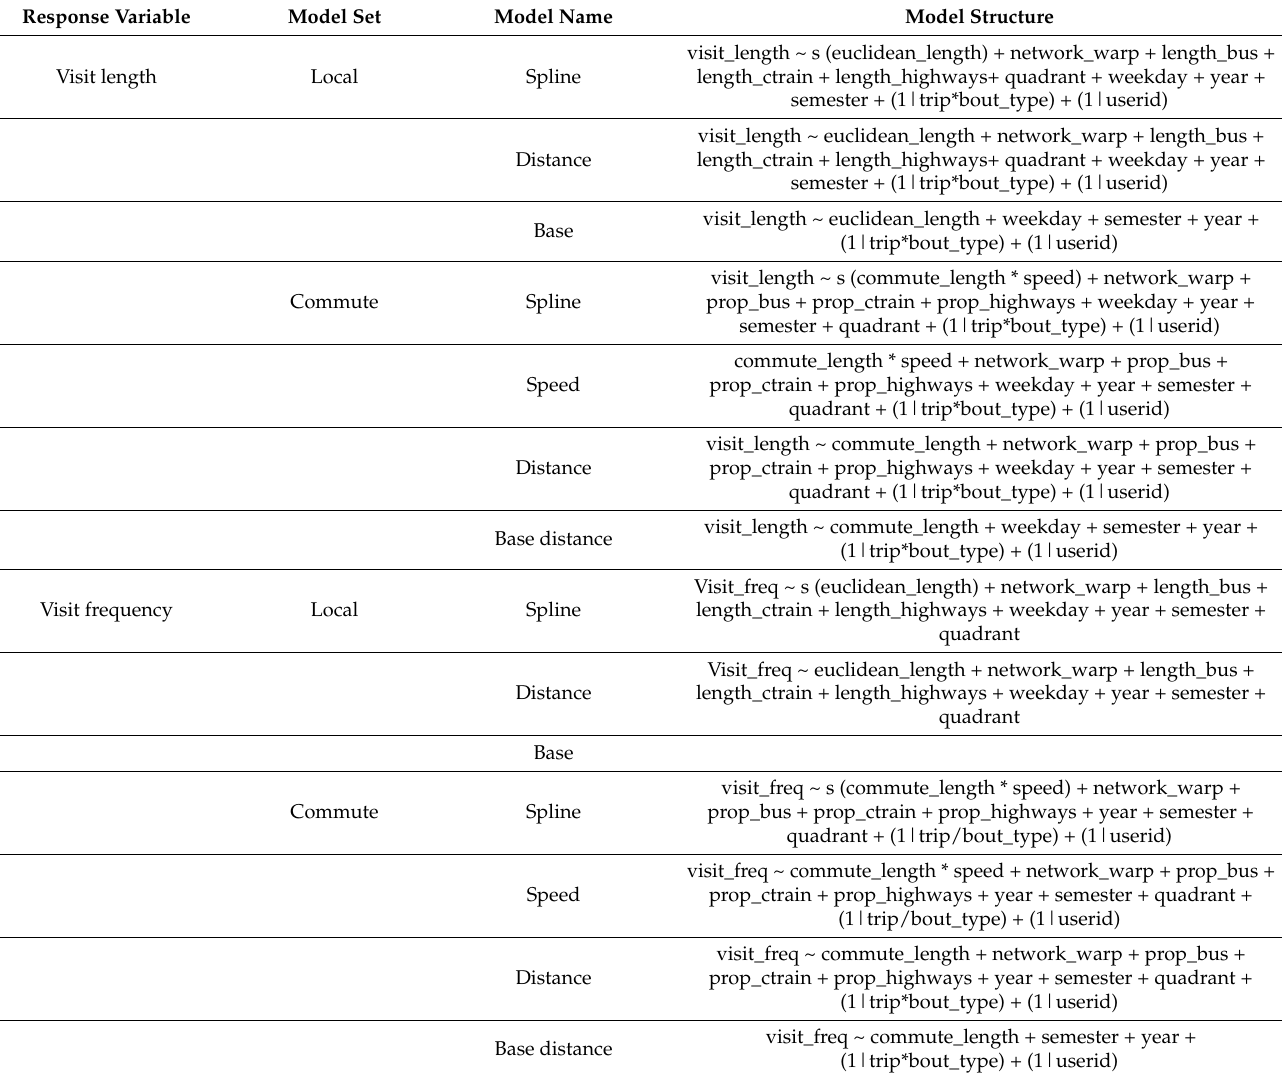
Table 2. Description of candidate models included in our two model sets: (1) visit length and (2) visit frequency. The notation “1|” represents a random effect, “*” represents an interaction effect and “s” indicates that the variable was incorporated as a spline term, rather than a linear